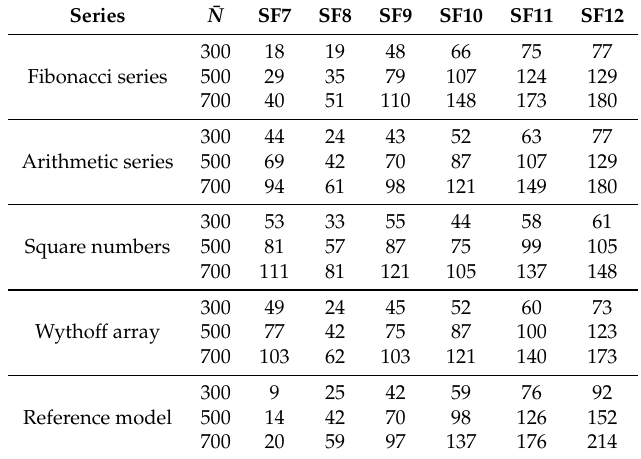
Table 4. Comparison of the proposed approach with the reference method, based on the number of